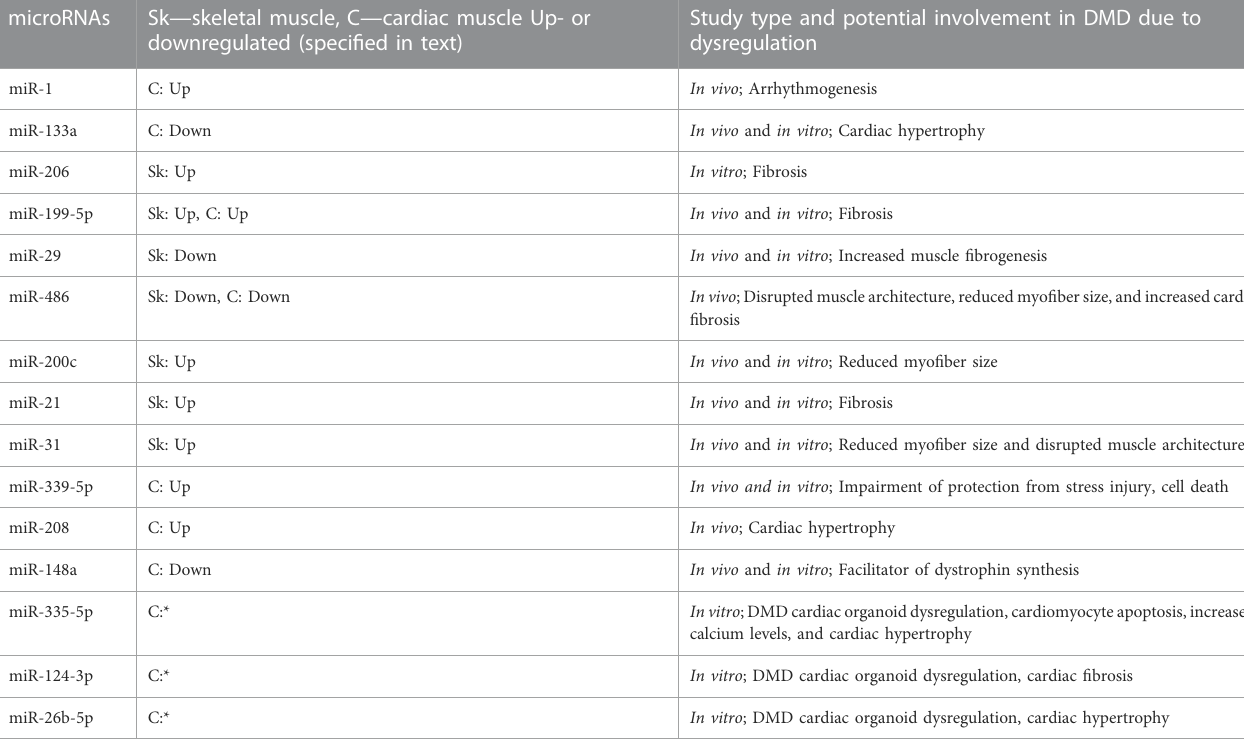
TABLE 1 An overview of dysregulated microRNAs (miRNAs) in Duchenne muscular dystrophy (DMD) described in the text. The columns represent the miRNAs, up- or downregulated in skeletal and/or cardiac muscle, and their potential involvement in DMD due to dysregulation ( in vivo and/or in vitro ).